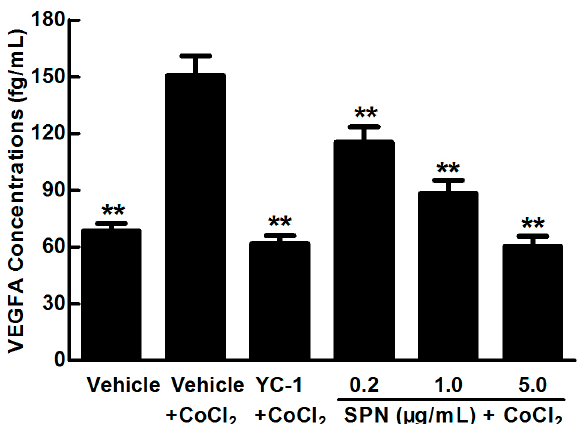
Figure 2. Effect of SPN on VEGFA secretion in ARPE-19 cells at 48 h of hypoxic condition. The results are representative of at least three independent experiments run in triplicate and expressed as the mean ± SD ( n = 9). ** p < 0.01 vs. vehicle plus CoCl 2 -treated group. The control cells were treated with vehicle (culture medium containing 0.1% DMSO).